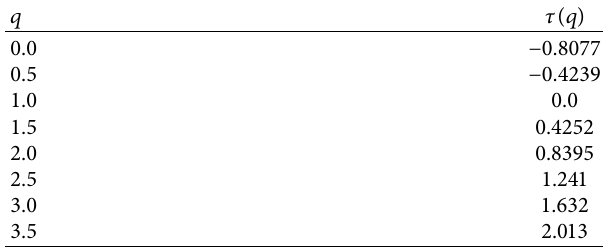
Table 1: The τ ( q ) − q relationship.